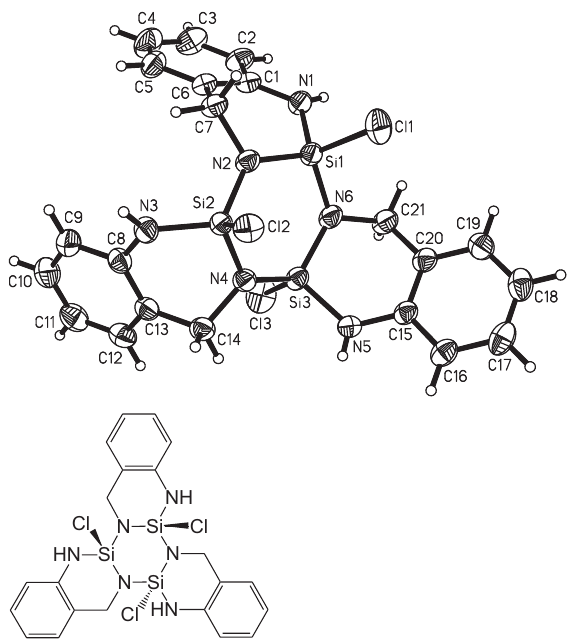
Figure 11: Molecular structure of 4f including numbering scheme (top). The thermal displacement ellipsoids of the non-hydrogen atoms are drawn at the 50% probability level. Schematic formula drawing of 4f (bottom).